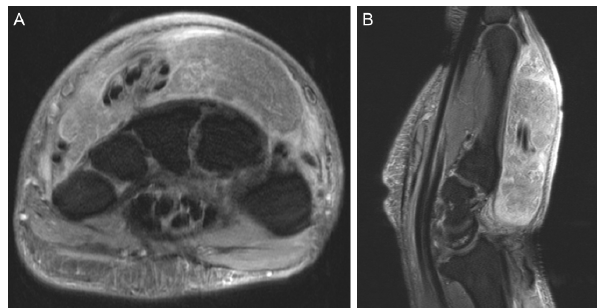
Figure 7. Representative (a) axial and (b) sagittal views of the right wrist and hand demonstrate no osseous changes secondary to os- teomyelitis on magnetic resonance imaging. Soft tissue edema is appreciable on the imaging.